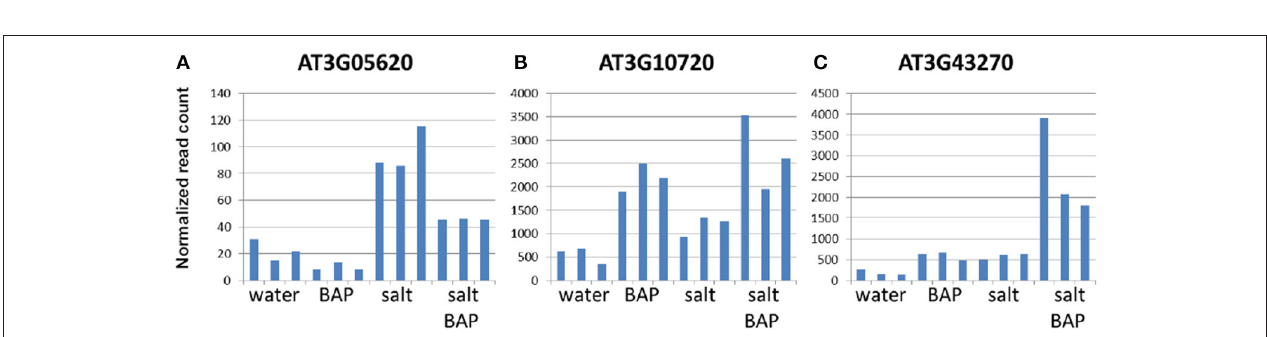
FIGURE 12 | Effect of CK on differential expression of expansins genes under salinity stress. (A) EXPA2 gene expression (B) EXPA1 gene expression (C) EXPA14 gene expression. Arabidopsis w.t. plants were grown for 30 days in optimal conditions and then leaves were detached and exposed to BAP 10 µ m, 120 mM NaCl, or salt plus BAP for 24 h. Controls were detached leaves in water. Three samples were collected from the controls and stressed leaves.